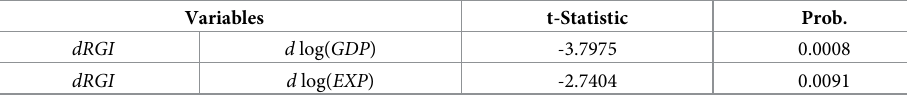
Table 5. Results of the cointegration test at the world